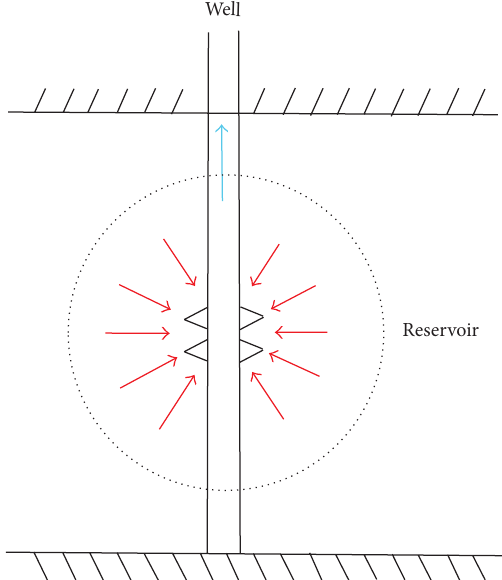
Figure 1: Schematic for spherical flow in a